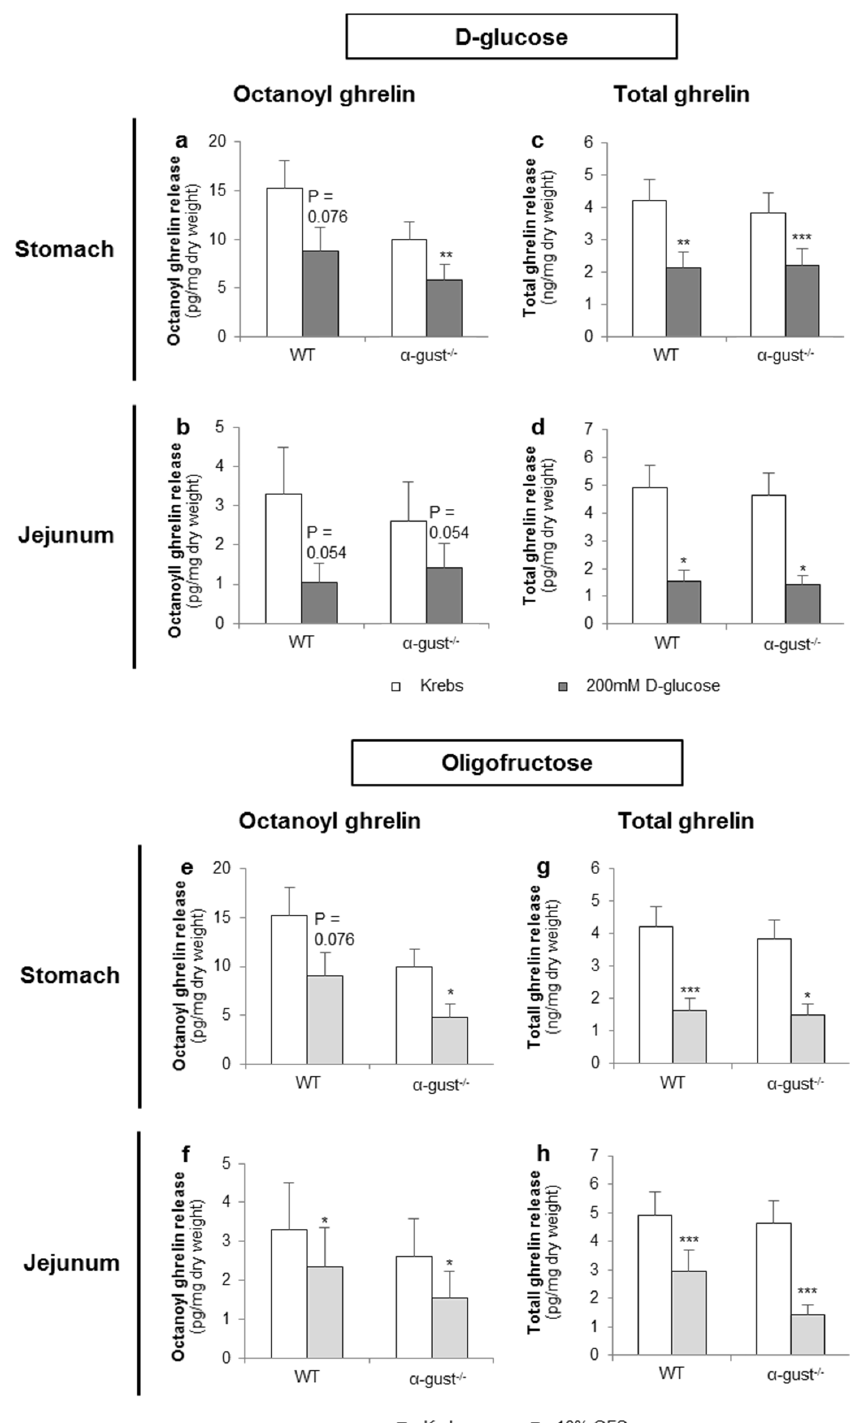
Figure 4. The effect of D -glucose and OFS on ghrelin release from segments of the corpus and jejunum is α -gustducin independent. Effect of 2-h stimulation with Krebs buffer or 200 mM D -glucose ( a – d ) or 10% OFS ( e – h ) on octanoyl ( a , b , e , f ) and total ghrelin release ( c , d , g , h ) from tissue segments of the corpus of the stomach ( n = 6) or the jejunum ( n = 6) from wild type (WT) and α -gustducin knockout ( α -gust − / − ) mice. Results are presented as predicted values ± standard error of the predicted values. * p < 0.05, ** p < 0.01, *** p < 0.001 vs. Krebs treated segments.